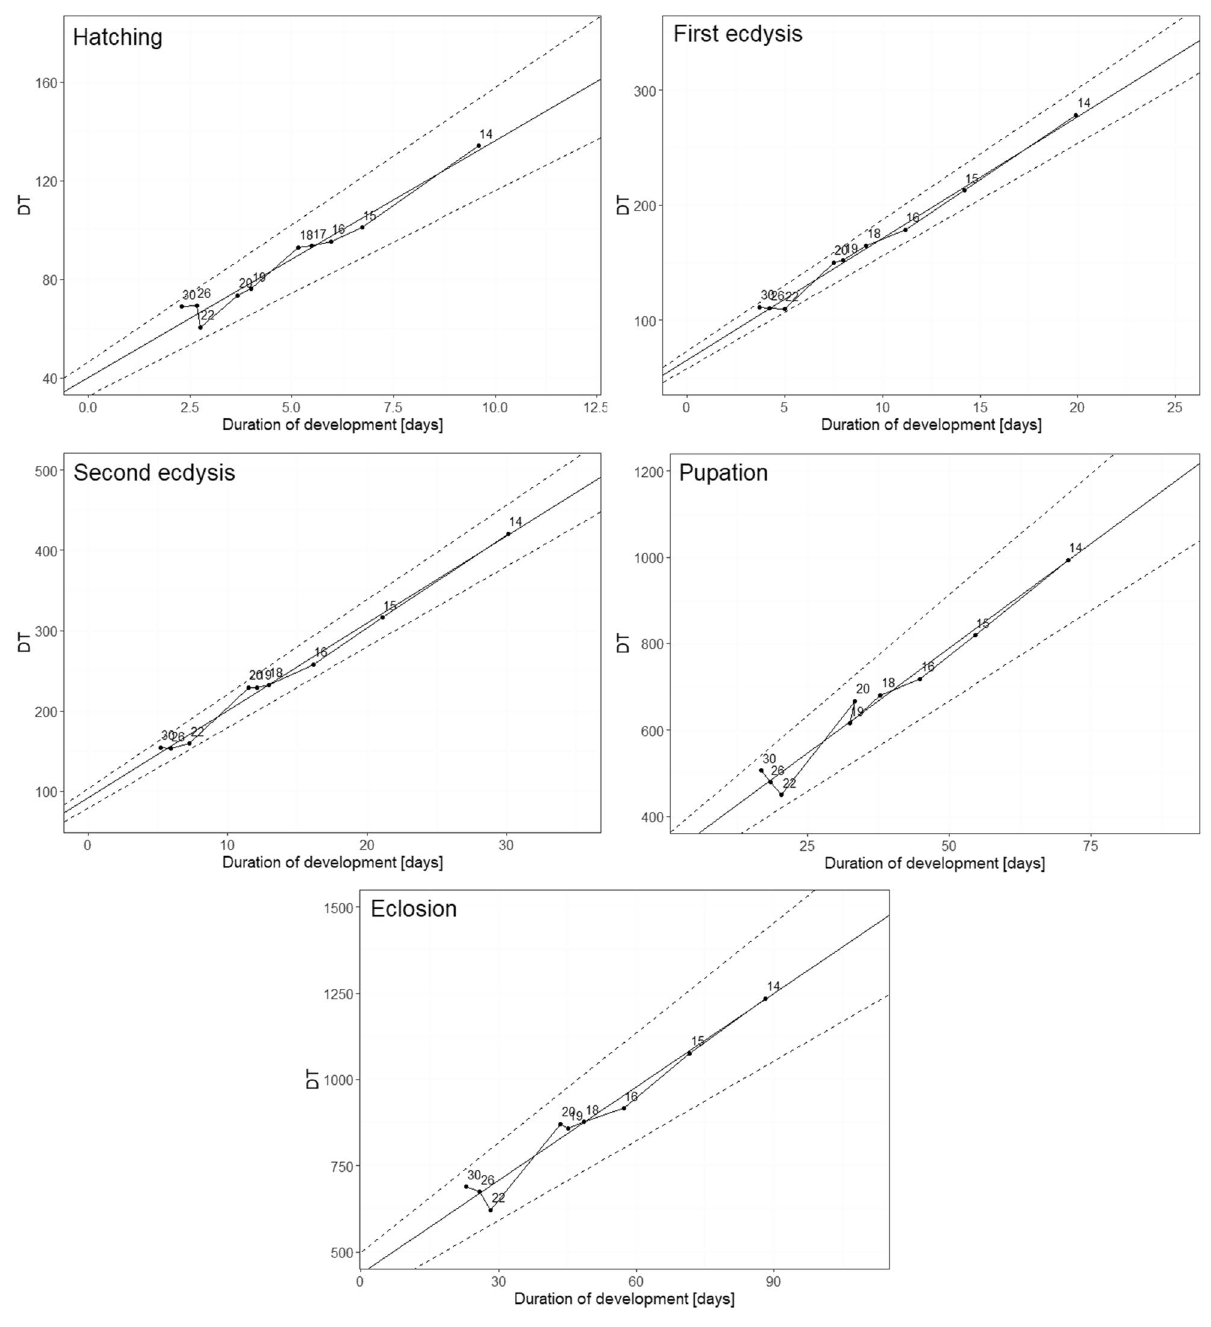
Figure 5. Reduced major axis (RMA) regression models for five developmental events of N. littoralis. DT is the time in days to reach developmental event multiplied by the constant rearing temperature. Temperature values are noted next to the points. Dashed lines represent 95% confidence